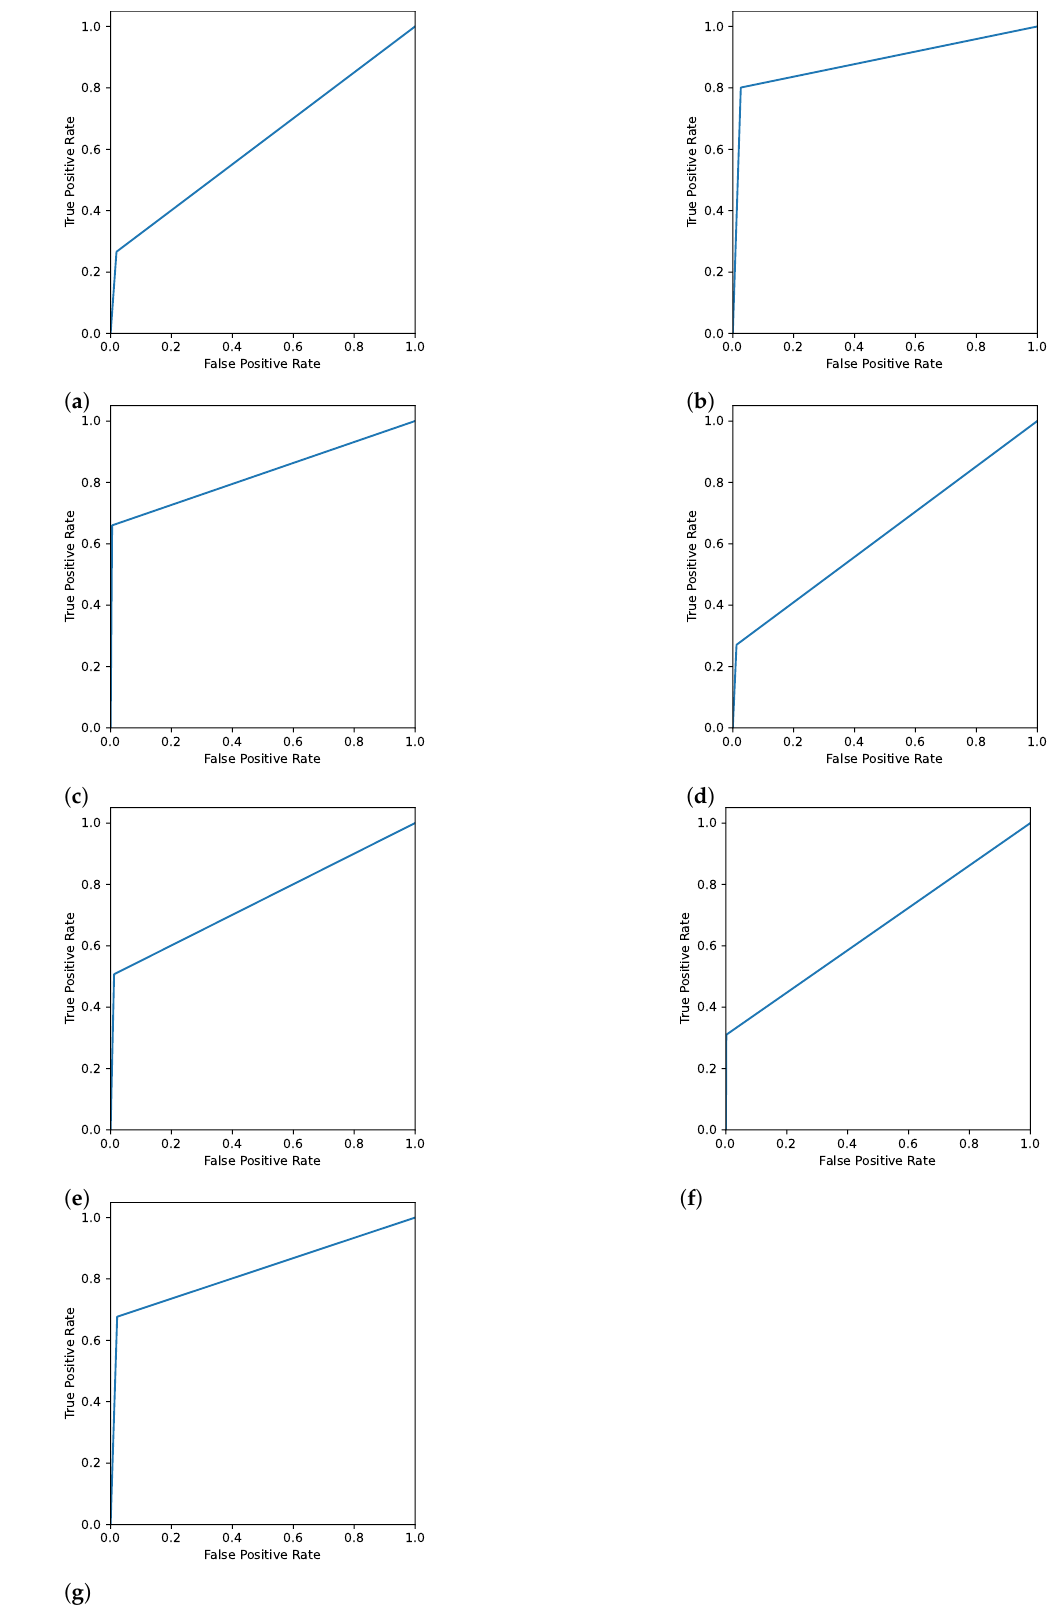
Figure 7. ROC curve for classification models: ( a ) logistic regression; ( b ) decision tree; ( c ) ran- dom forest; ( d ) support vector classifier; ( e ) AdaBoost; ( f ) extra tree classifier; and ( g ) artificial neural